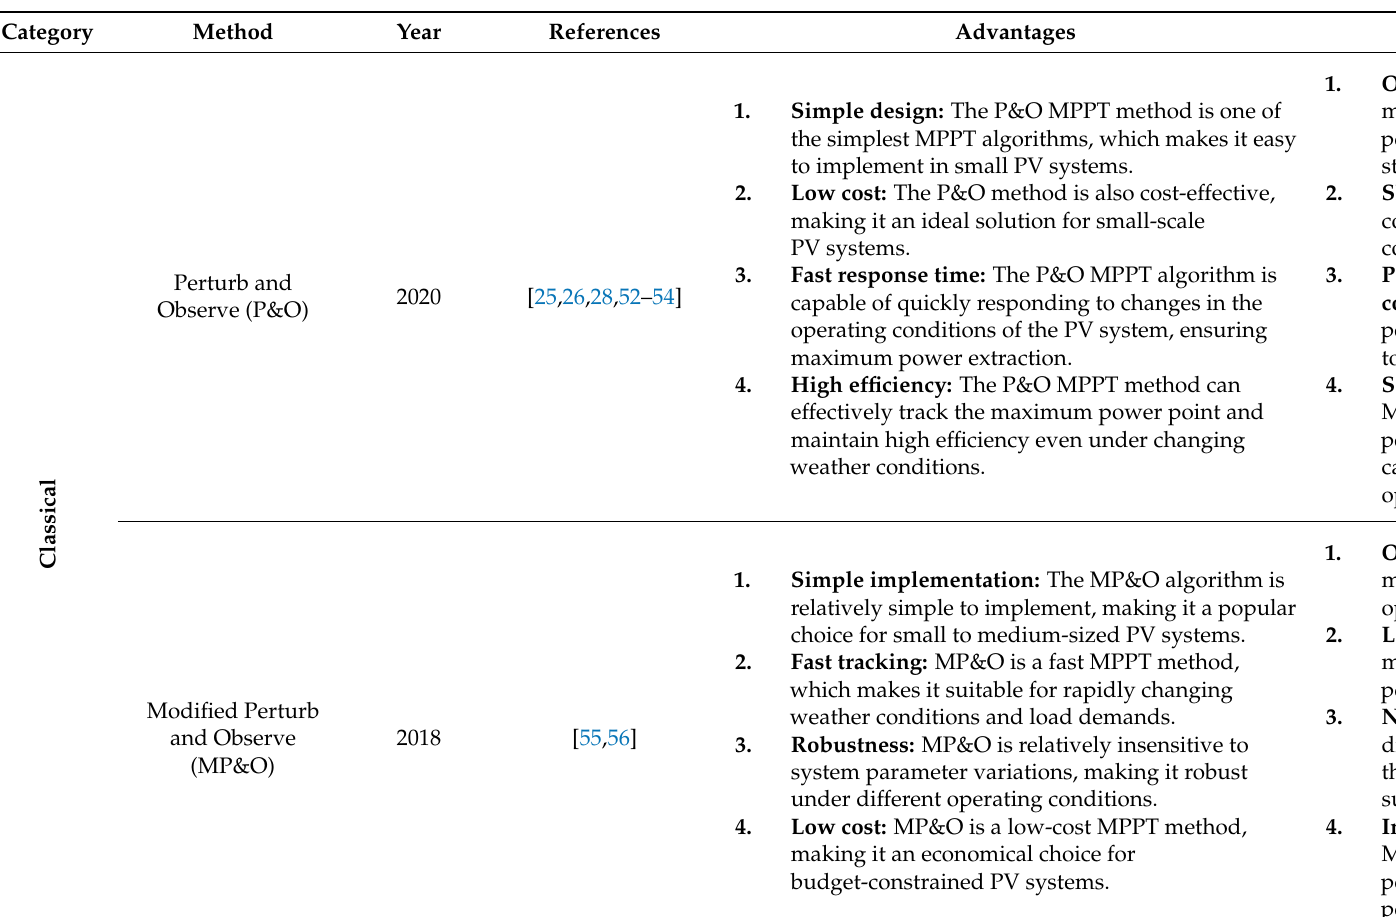
Table 3. Comparison of the MPPT algorithms for PV